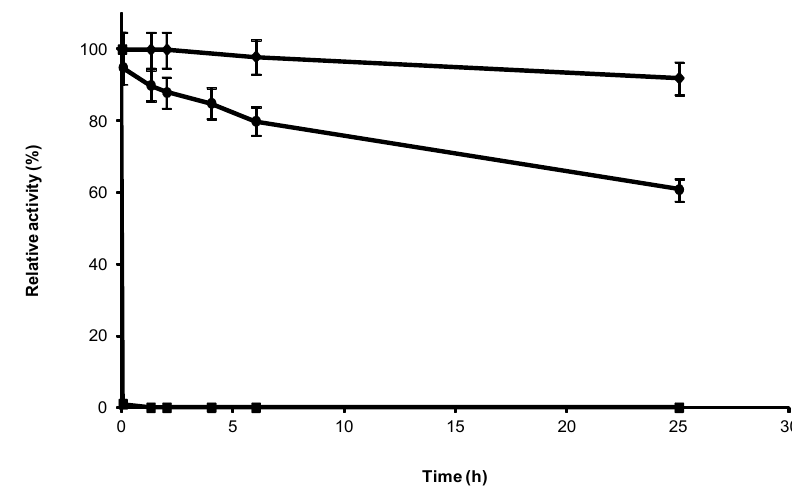
Figure 2. Stability of purified CRL at 25 °C and different pHs: pH 7 (rhombus), pH 9 (circles), pH 10 (squares); 0.27 mg purified free lipase was used in each experiment.